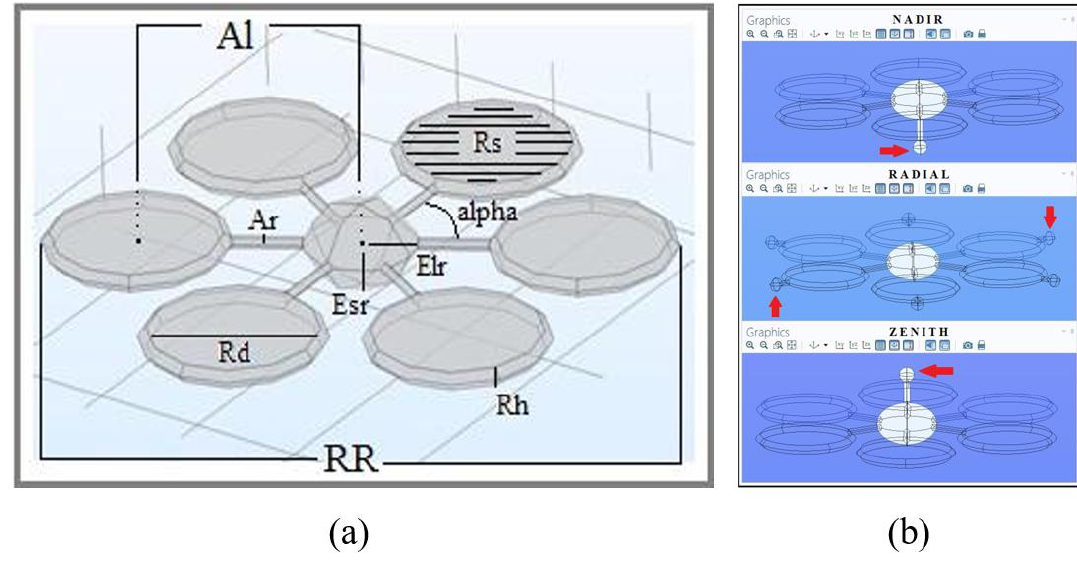
Figure 4. Schematics of the drone design with geometrical parameters ( a ) and positions of the sensors ( b ).